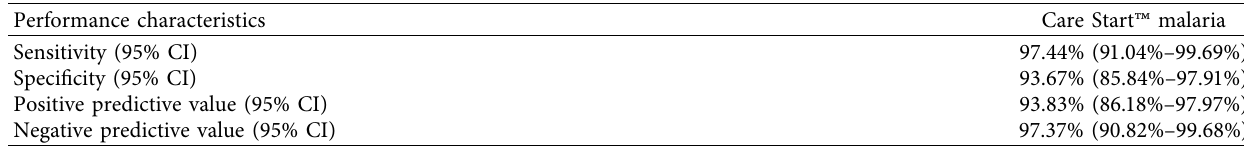
Table 4: Performance characteristics of Care Start ™ by species identified in comparison with the standard light microscopy, Arba Minch, 2016.